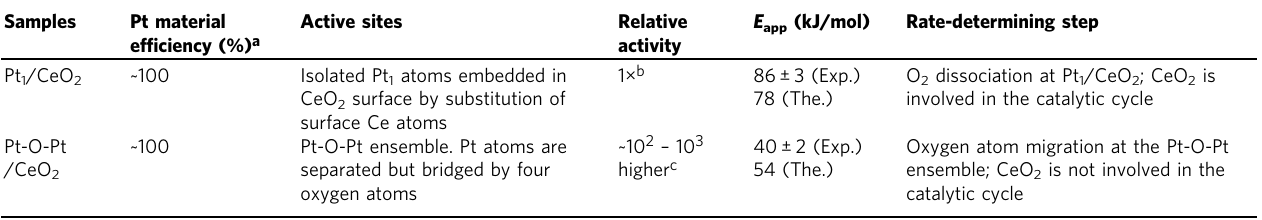
Table 1 Key metrics of the Pt 1 /CeO 2 and the Pt-O-Pt/CeO 2 catalysts Samples